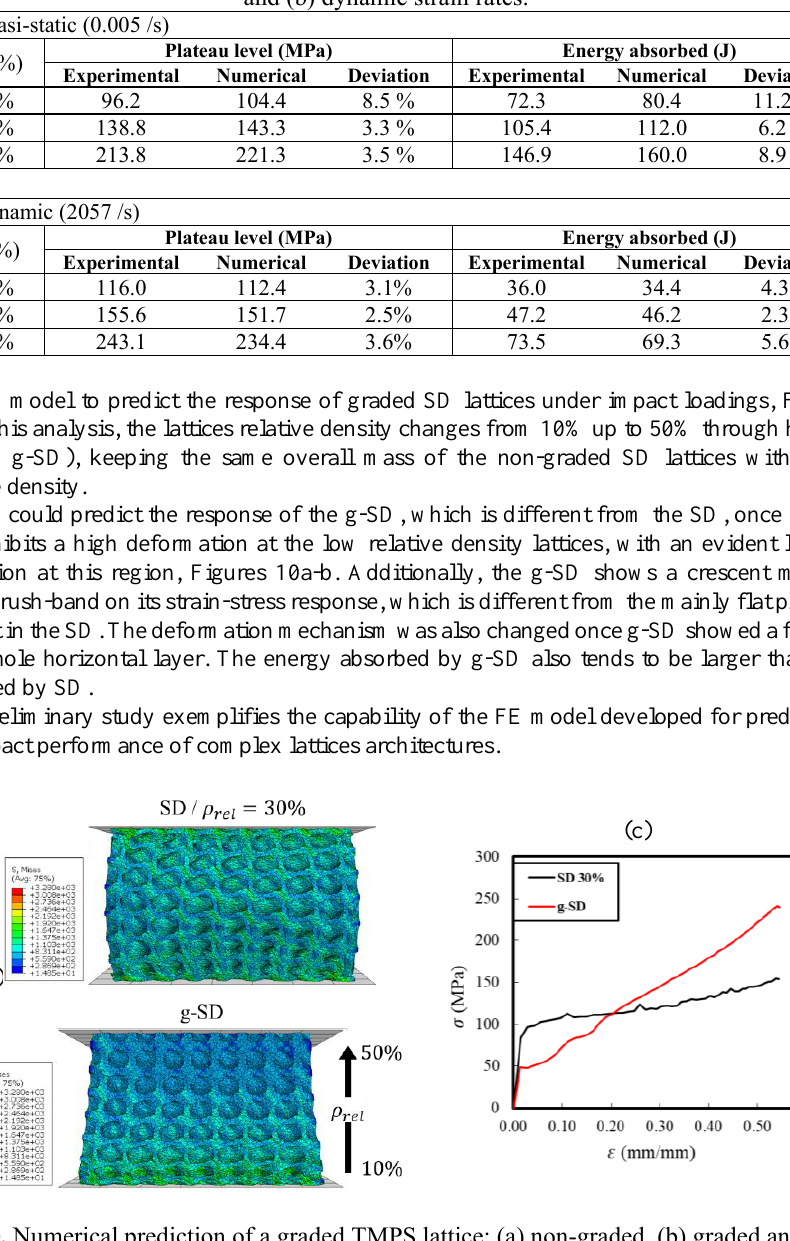
Fig. 10. Numerical prediction of a graded TMPS lattice: (a) non-graded, (b) graded and (c) strain-stress